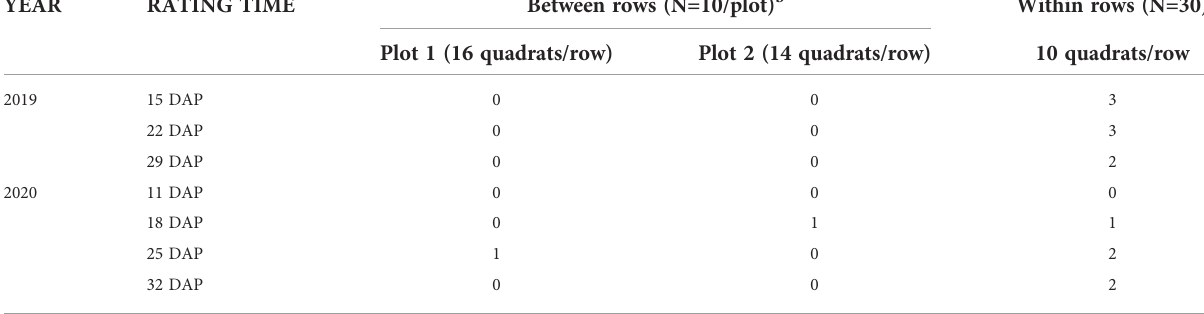
plants. Patches of WTVC infected plants initially occurring along the edge (along X-axis) of the fi eld, as observed in experimental fi elds, were also observed in commercial fi elds such as in “ Squash 4 ” and “ Squash 17 ” (Figures 7D, E). Only the side along the X-axis is considered as an edge in commercial fi elds because the other sides were also planted with squash. The pattern WTVC spread in “ Squash 3 ” (Figure 7A) deviated from patterns observed in experimental fi elds. In “ Squash 3 ” , the patches observed during initial assessment did not converge, instead new smaller patches developed around the fi eld.